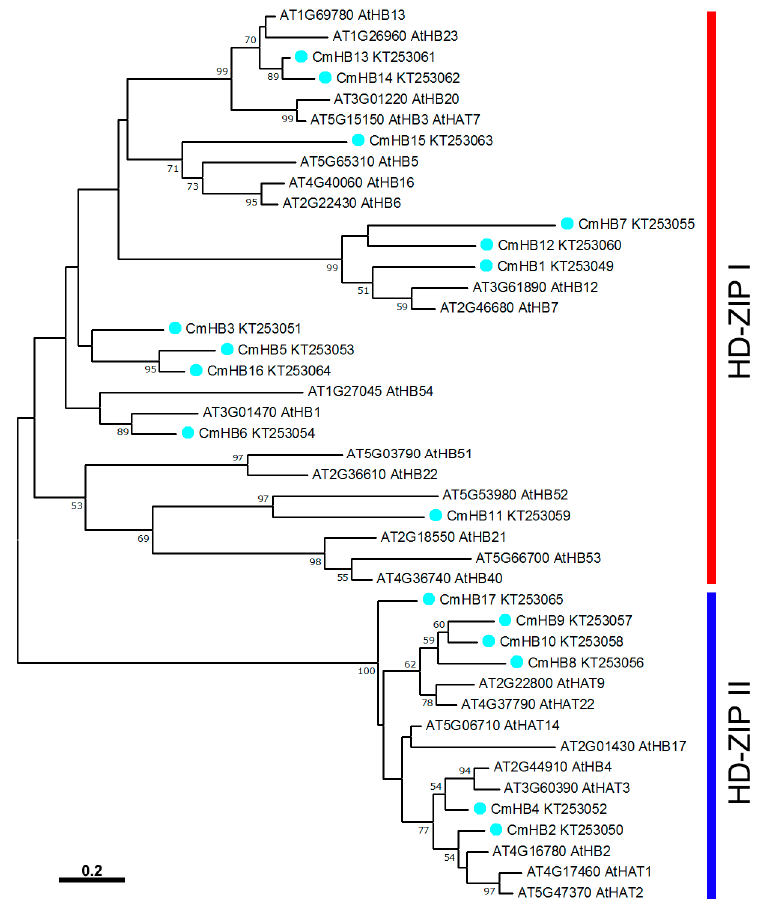
Figure 1. Phylogenetic tree for the Arabidopsis and chrysanthemum HD-Zip I & II proteins. The tree was constructed from a complete alignment of 26 Arabidopsis and 17 chrysanthemum HD-Zip proteins using the Maximum Likelihood method. Bootstrap values below 50% have been omitted.